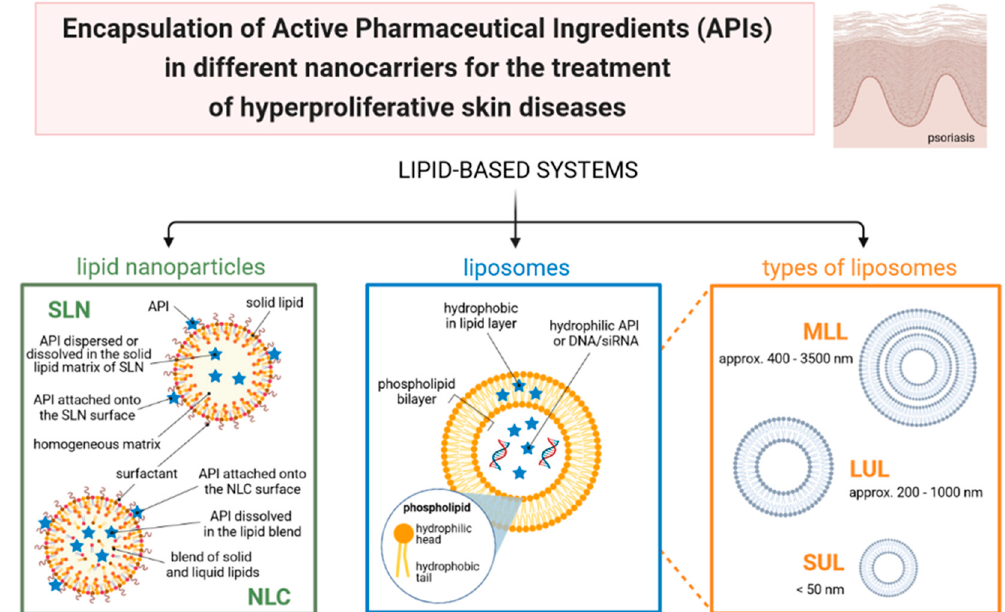
Figure 1. Schematic representation of the encapsulation of active pharmaceutical ingredients (APIs) in different types of lipid nanocarriers [own drawing].